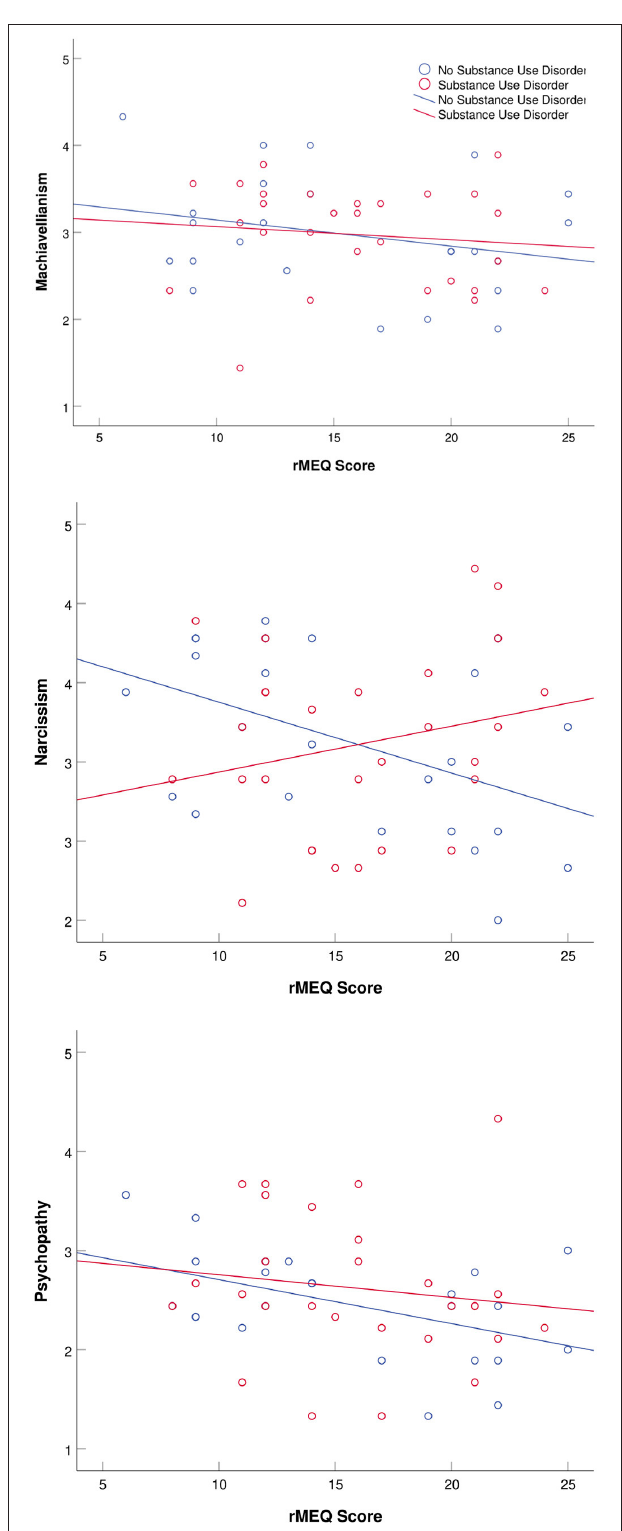
FIGURE 2 | Scatter plots dark triad trait scores and reduced Morningness–Eveningness Questionnaire (rMEQ) scores separated by substance use disorder and non-substance use disorder populations. Low rMEQ scores indicate preference eveningness and high scores indicate preference for